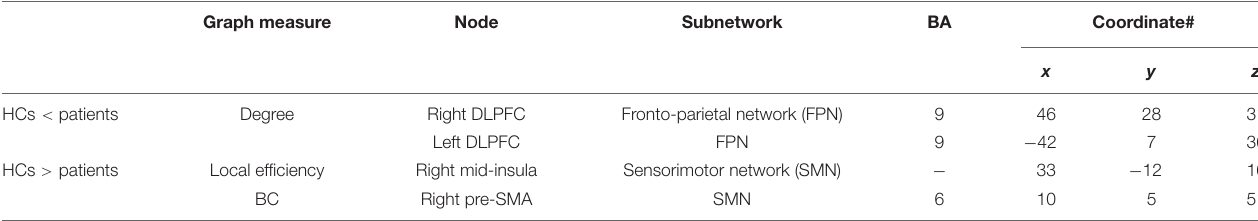
TABLE 2 | Graph measure changes in patients with PD compared with